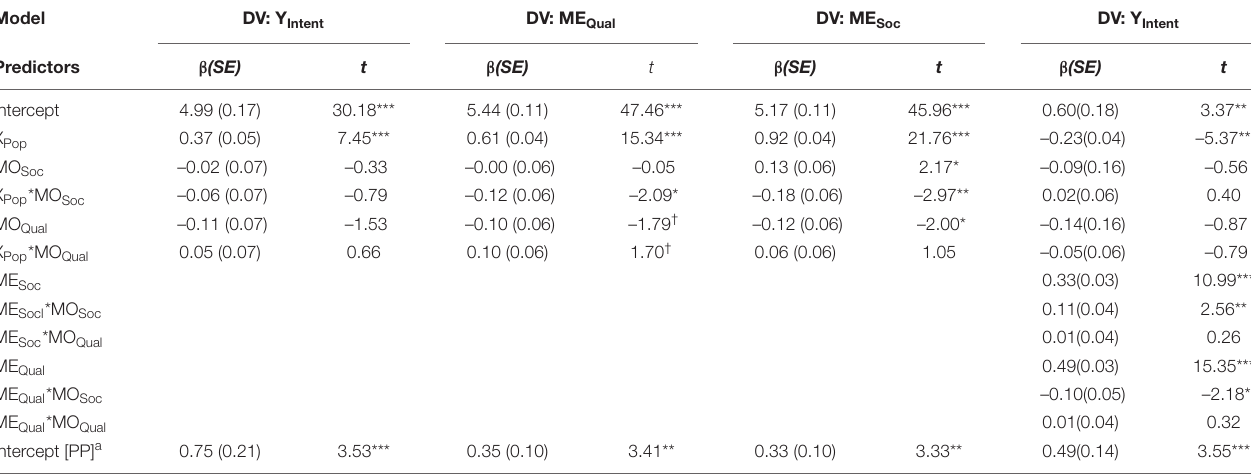
TABLE 1 | Overview test statistics and parameters for behavioral focus